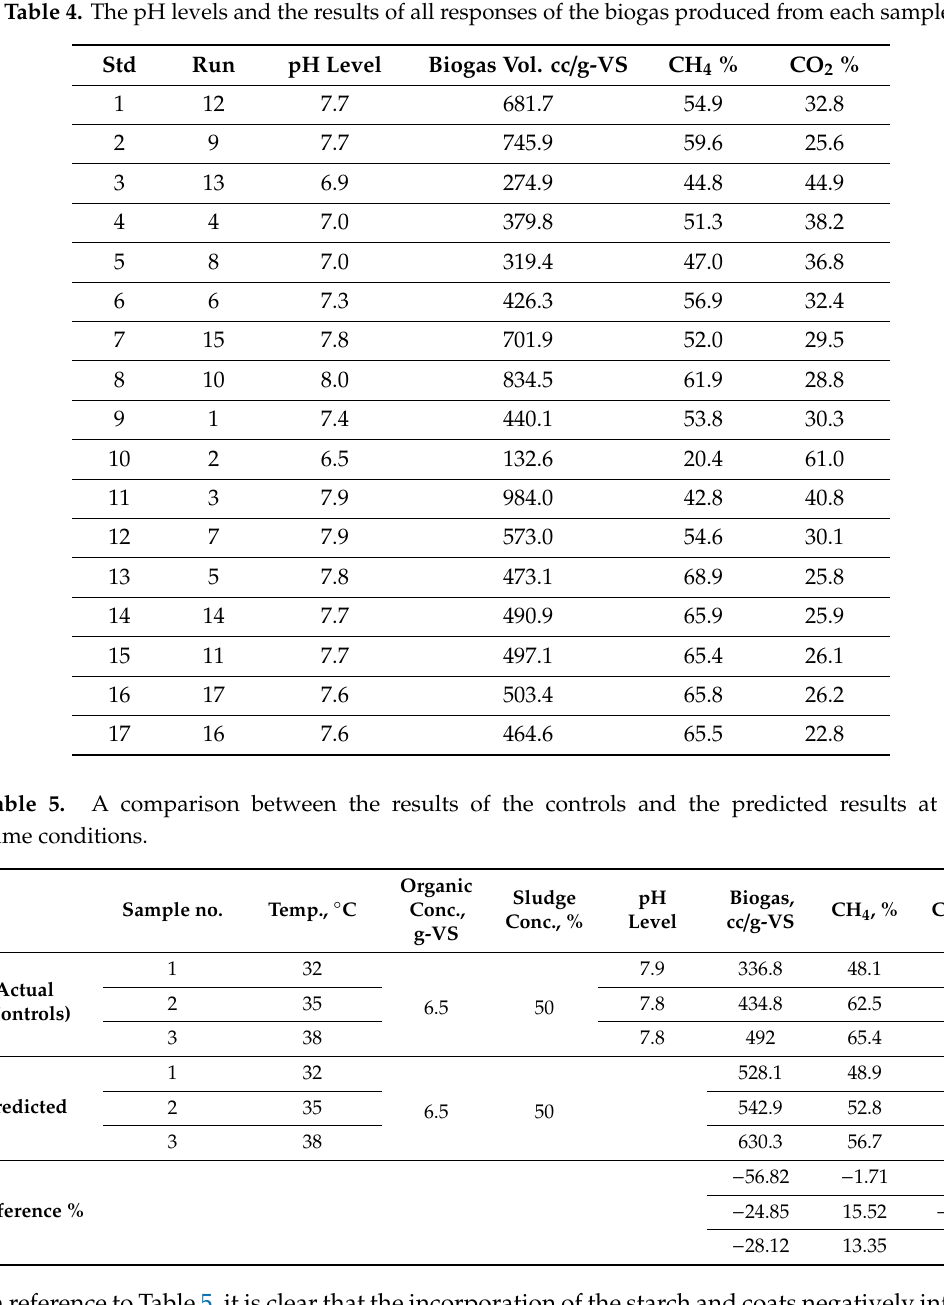
Table 4. The pH levels and the results of all responses of the biogas produced from each sample.